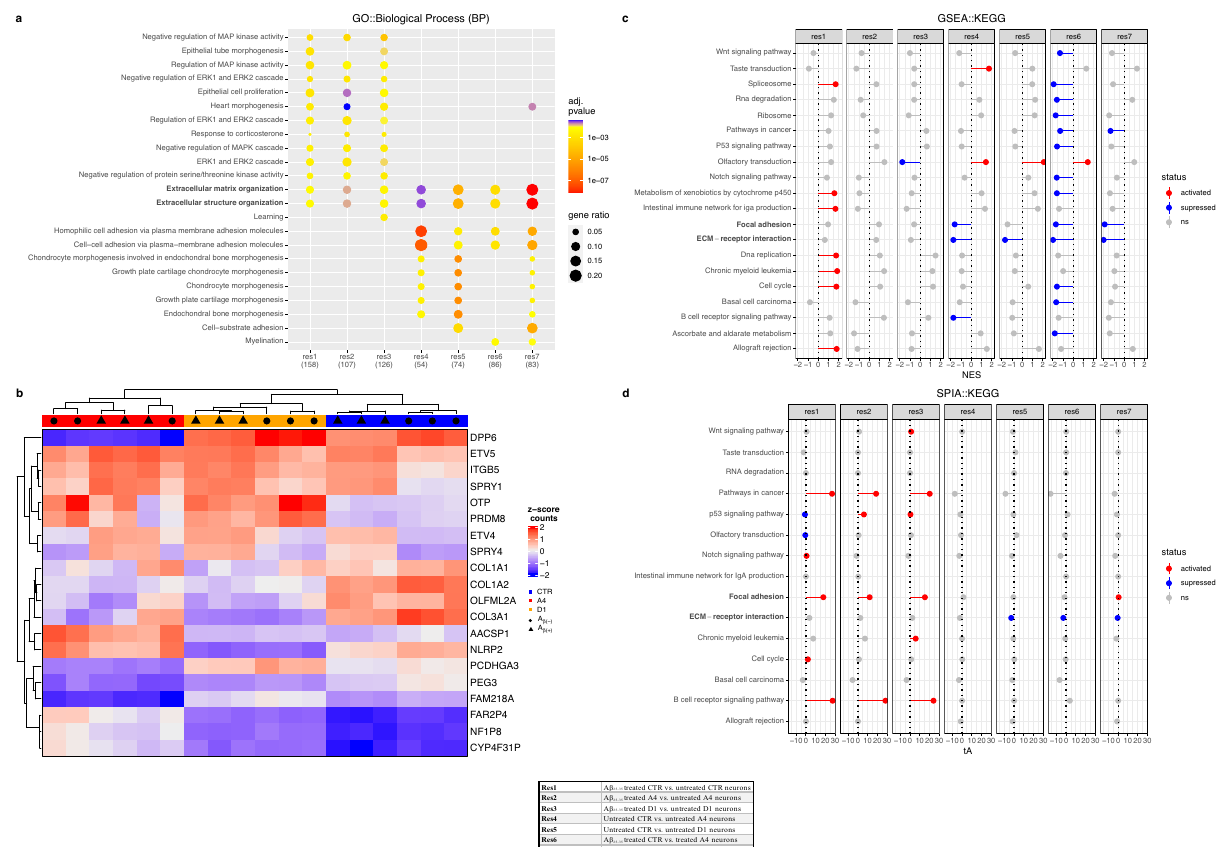
Figure 4. Extracellular matrix (ECM) genes and pathways are downregulated in exon 2 −/− neurons. RNA- Seq analysis of exon 2 −/− and CTR neurons reveal suppression of ECM related genes and pathways in exon 2 −/− neurons. ( a ) GO (biological process) enrichment analysis reveal downregulation of collagen and ECM genes in exon 2 −/− neurons (res 4 and 5). ( b ) Heatmap visualisation of top 20 most variable genes clustered with complete hierarchical clustering using z-scored counts. Column annotations represent Aβ 25–35 treatment condition and neuron genotype (CTR, A4 or D1). ( c ) Functional directionality analysis identified focal adhesion and ECM receptor interaction were suppressed in exon 2 −/− neurons, which was not altered by Aβ 25–35 treatment. ( d ) Topology identified a significant suppression of ECM-receptor interaction and PI3K- Akt signalling pathways were suppressed in exon 2 −/− neurons, again unaltered by Aβ 25–35 . Figure